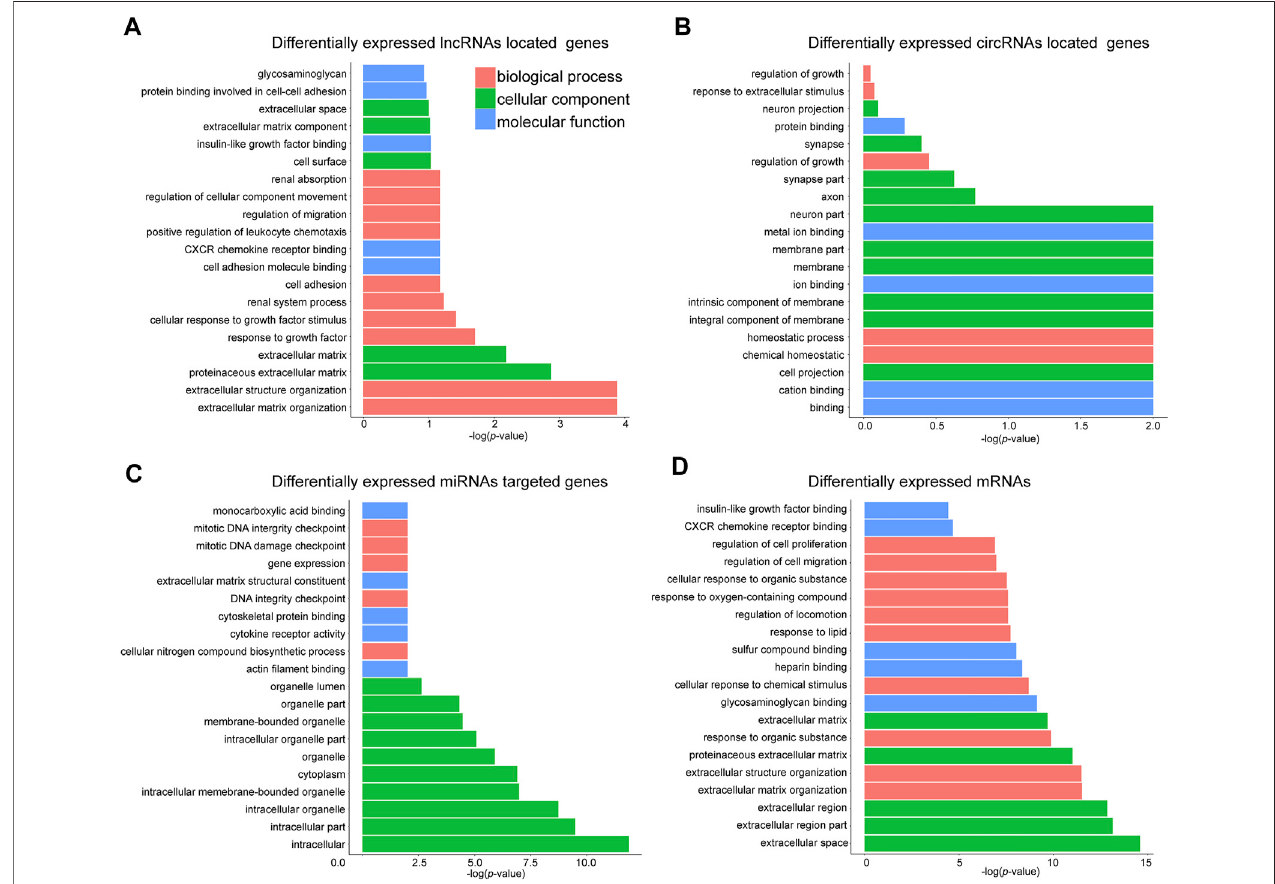
FIGURE 3 | GO analysis of DE mRNAs, lncRNAs, circRNAs and miRNAs. Top 20 terms of Gene Ontology (GO) enrichment analysis regarding (A) DE lncRNAs- located genes; (B) DE circRNAs-located genes; (C) DE miRNAs-targeted genes; and (D) DE mRNAs.